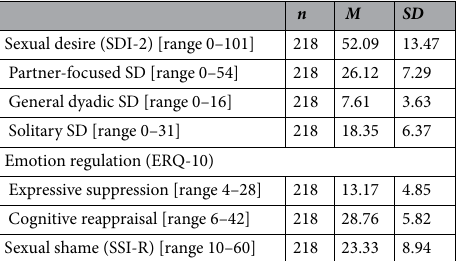
Table 1. Summary of means and standard deviations for scores on the SDI-2, ERQ-10, and SSI-R. SDI‑2 sexual desire inventory-2, ERQ‑10 emotion regulation questionnaire, SSIR sexual same inventory—revised.